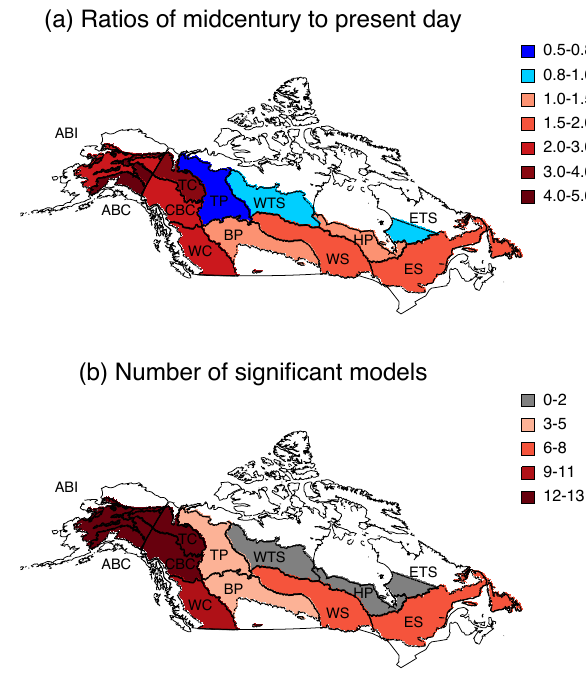
Figure 7. (a) Median ratios of mid-century (2048–2064) to present- day (1983–1999) area burned in each boreal ecoregions, as pre- dicted by an ensemble of GCMs and (b) the number of GCMs out of 13 total which predict significant changes of the same sign as the median. The ecoregions are: Alaska Boreal Interior (ABI), Alaska Boreal Cordillera (ABC), Taiga Cordillera (TC), Canadian Boreal Cordillera (CBC), Western Cordillera (WC), Taiga Plain (TP), Bo- real Plain (BP), Western Taiga Shield (WTS), Eastern Taiga Shield (ETS), Hudson Plain (HP), Western Mixed Wood Shield (WS), and Eastern Mixed Wood Shield